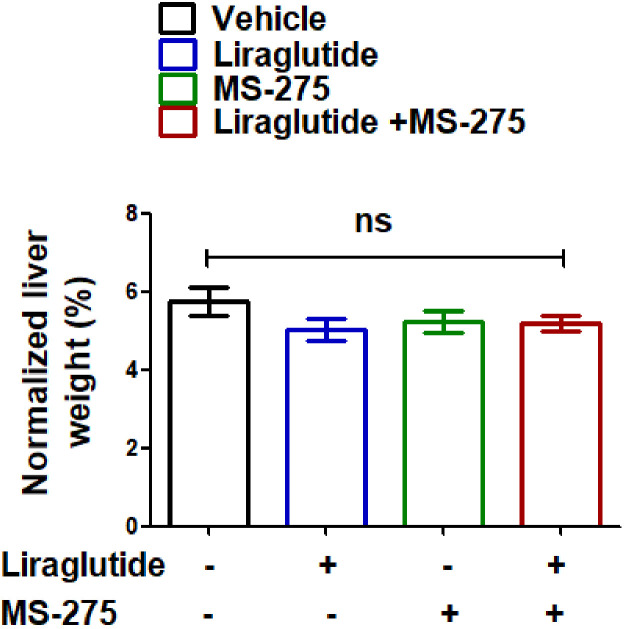
Effect of MS-275, liraglutide monotherapy, and combined therapy or the vehicle control on the liver weight, the data represent mean ± S.E; ns: non-significant.